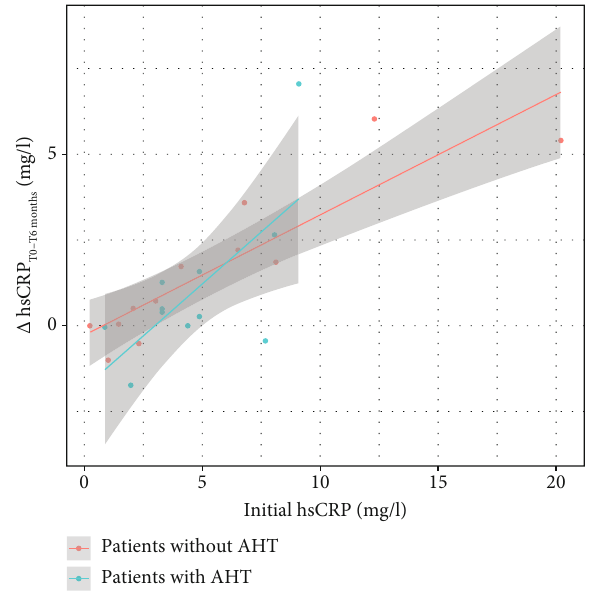
Figure 4: Linear regression model showing the correlation of the amplitude of variations in hs-CRP serum levels after a 6-month- nCPAP therapy ( Δ hs-CRP [T0-T6]) with baseline levels of serum hs-CRP for hypertensive and normotensive OSAHS patients. In both groups, ( Δ hs-CRP [T0-T6]) were more marked in patients with higher baseline hs-CRP serum levels. hs-CRP: high-sensitivity C-reactive protein. nCPAP: nocturnal continuous positive airway pressure. OSAHS: obstructive sleep apnea-hypopnea syndrome. AHT: arterial hypertension. Δ hs-CRP [T0-T6-month-CPAP